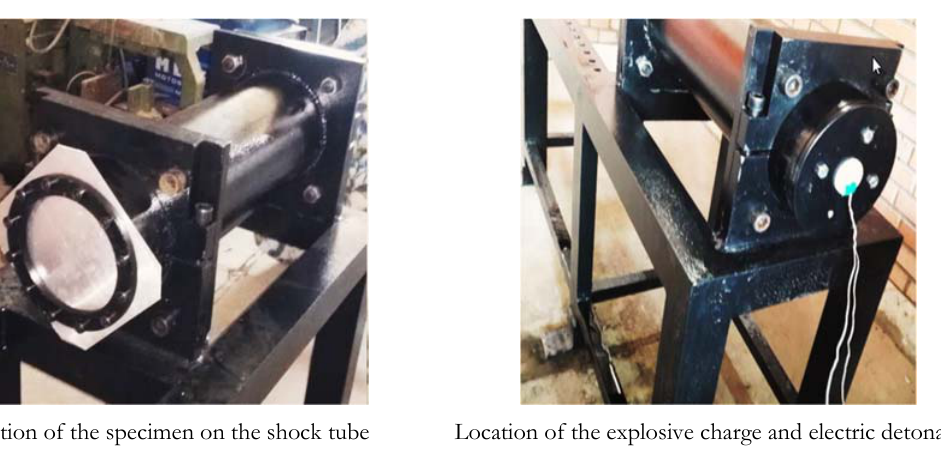
Figure 13: Shock